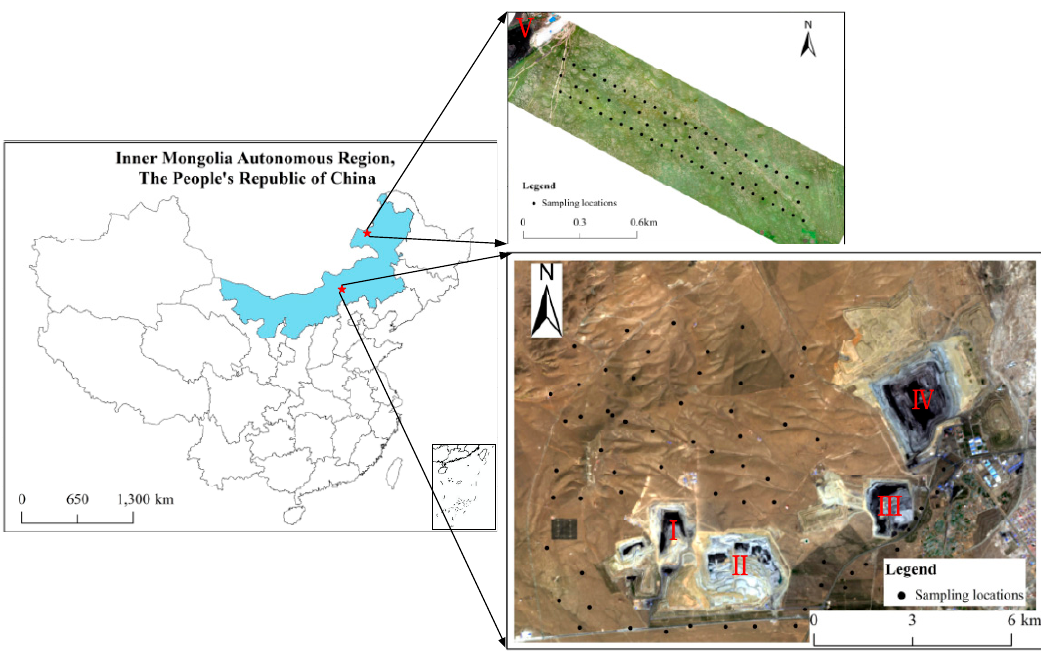
Figure 2. Locations of the study areas. I: Wulantuga Germanium Mine; II: West Open-pit Mine-2; III: West Open-pit Mine-3; IV: Shengli Open-pit Mine-1; V: Hulunbuir Dongming Mine.